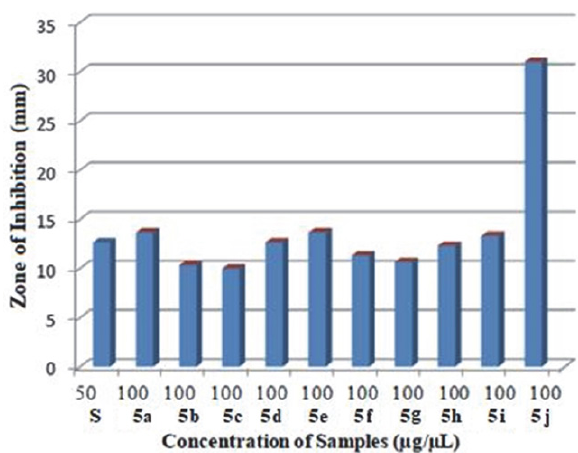
Figure 6. Antibacterial activity of acyl thioureas against S. aureus.